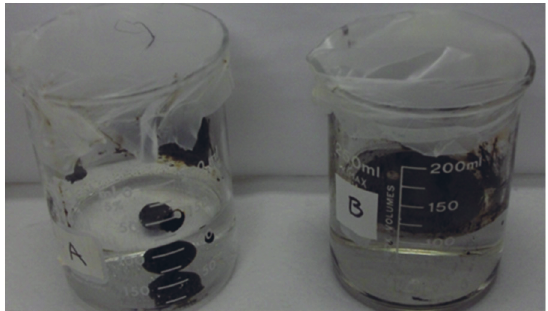
Figure 5. Bitumen samples in deionized water ( A ) and Instant Ocean solution ( B ) at room temperature (23 °C) and time = 96